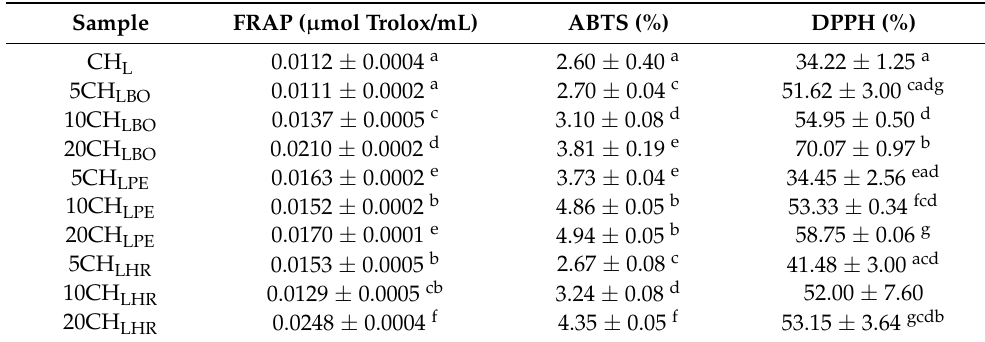
Table 12. Migration–antioxidant